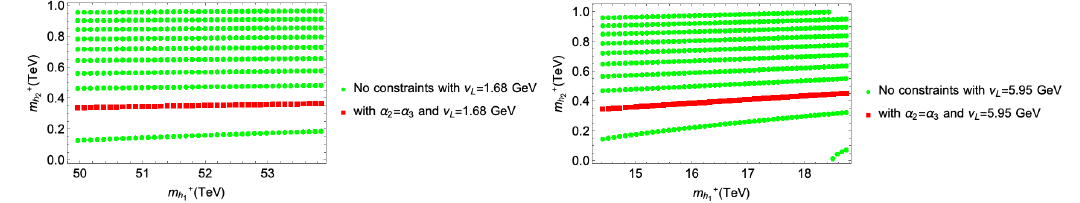
Figure 10 . Parameter space allowed for the charged Higgs masses on the VEV v L while varying µ 3 and α 2 , α 3 . Left: v L = 1 . 68 GeV, Right: v L = 5 . 95